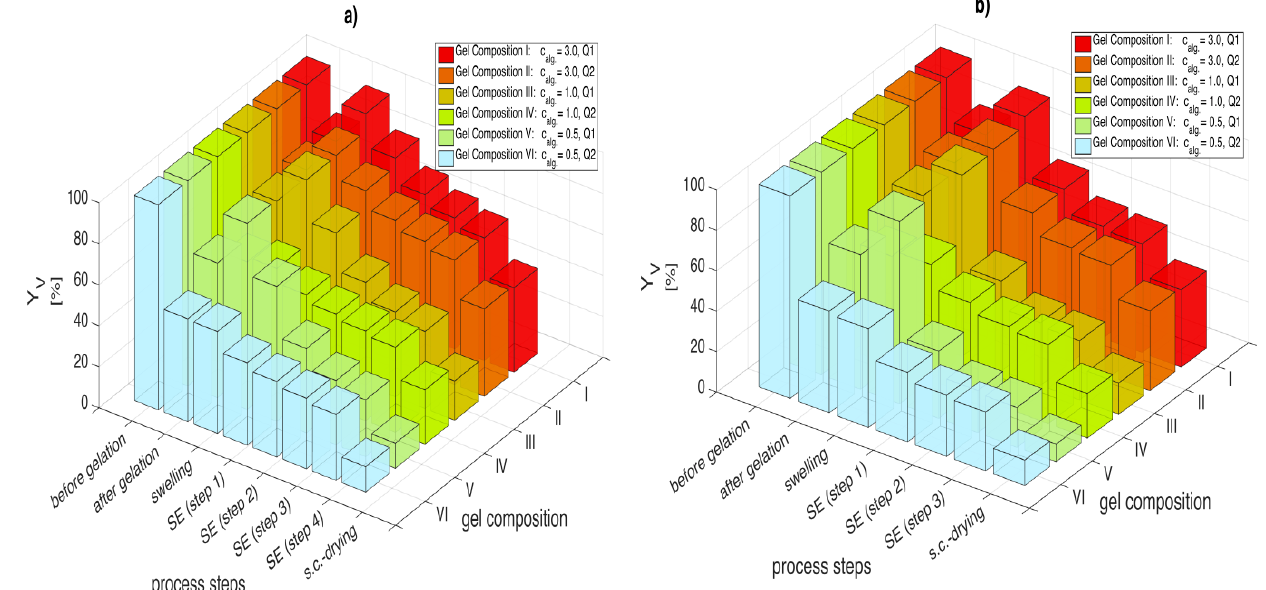
Figure 5. Volumetric yields after gelation, swelling, each process step for solvent exchange with ethanol and supercritical CO 2 drying; for ( a ) Δ c = 30 wt % and ( b ) Δ c = 50 wt %. Numerical data for each solvent composition are given in supplementary materials associated with this paper (Tables S1 and